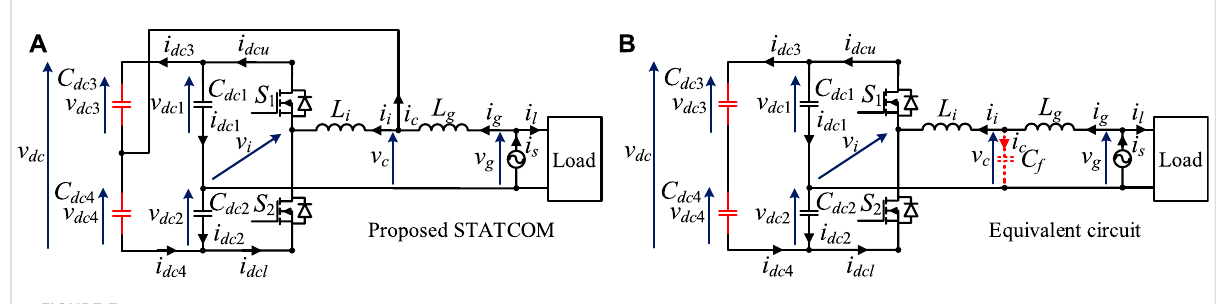
FIGURE 3 Circuit diagrams of (A) the proposed LCL - fi ltered half-bridge DSTATCOM and (B) its equivalent circuit.